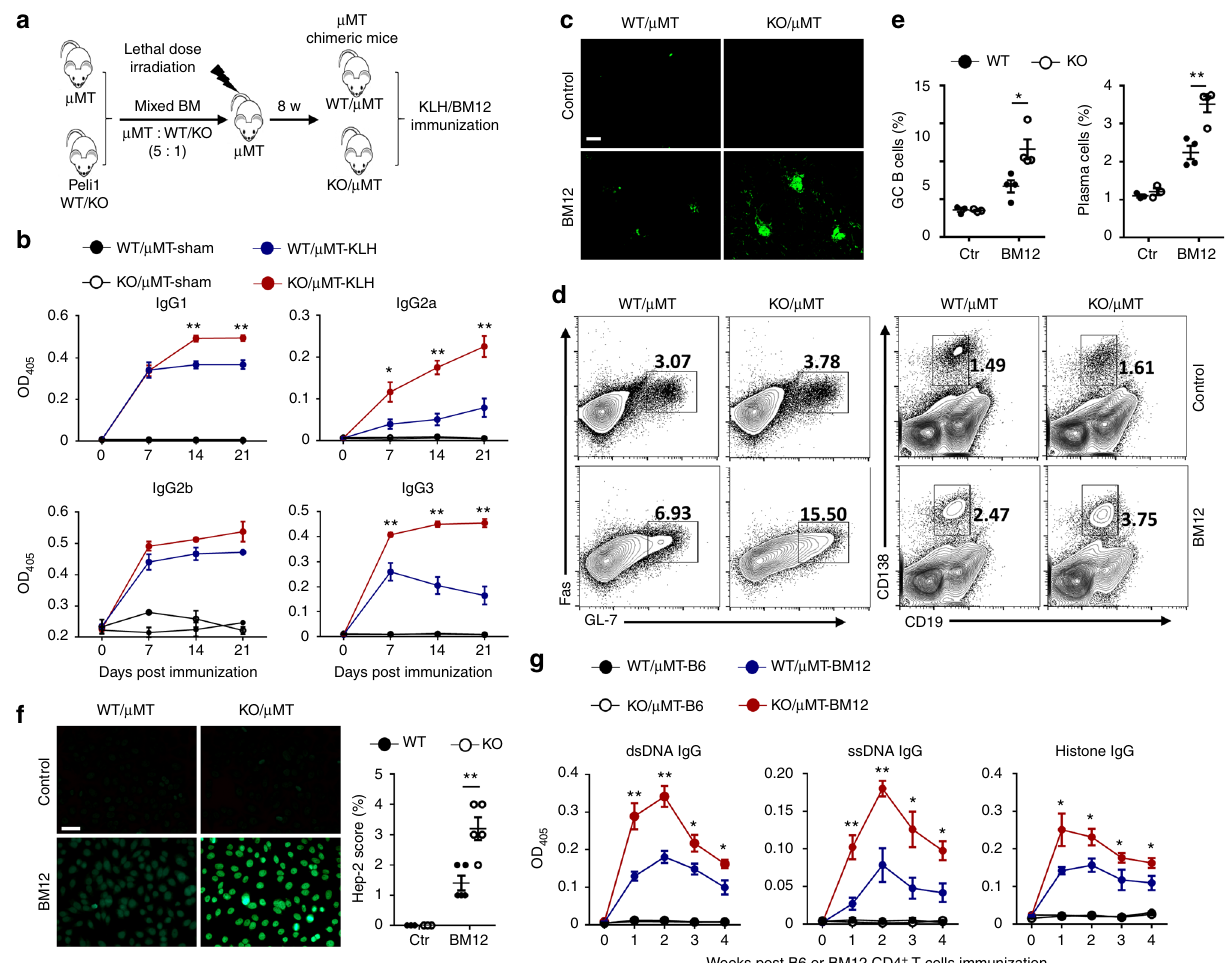
Fig. 3 Peli1 de fi ciency speci fi cally in B cells promotes autoimmunity in vivo. a Scheme showing how the μ MT chimeric mice were constructed for immunization. b Enzyme-linked immunosorbent assay (ELISA) of NP-speci fi c IgG1, IgG2a, IgG2b, and IgG3 in the serum of WT/ μ MT and Peli1-de fi cient (KO)/ μ MT chimeric mice that immunized intraperitoneally with vehicle (sham) or NP-KLH (KLH). c WT/ μ MT and KO/ μ MT chimeric mice were intraperitoneally injected with 7.5 million of CD4 + T cell from C57BL/6 mice (control) or from BM12 mice. Representative immuno fl uorescent images showing IgG deposits in kidney by staining with Alexa Fluor 488-labeled anti-mouse IgG. Scale bar, 100 μ m. d , e Flow cytometric analysis of the percentages of Fas + GL-7 + germinal center (GC) B cells and CD19 − CD138 + plasma cells in immunized WT/ μ MT and KO/ μ MT chimeric mice as described in ( c ). Data are presented as the representative FACS plots ( d ) and summary graphs ( e ). f Distinct anti-nuclear antibody (ANA) staining patterns of the Hep-2 cell line with serum from WT/ μ MT and KO/ μ MT chimeric mice 4 weeks after immunization as described in ( c ). Ctr represents control in the right panel bar graph. Scale bar, 50 μ m. g Enzyme-linked immunosorbent assay (ELISA) of anti-dsDNA, anti-ssDNA, and anti-histone IgG in serum from immunized WT/ μ MT and KO/ μ MT chimeric mice as described in ( c ) at the indicate time point. Data are shown as the mean ± SEM based on three independent experiments. Two-tailed Student ’ s t- tests were performed. * P < 0.05 and ** P < dose irradiated B cell-de fi cient μ MT mice with the mixed BMs from μ MT mice and Peli1 WT/KO mice ( μ MT: Peli1 WT/KO = 5: 1) (Fig. 3a). In these chimeric mice, μ MT mice BM will provide all the genetic-competent immune cells except for B cells, and Peli1 WT/KO mice BM will provide the Peli1-competent or